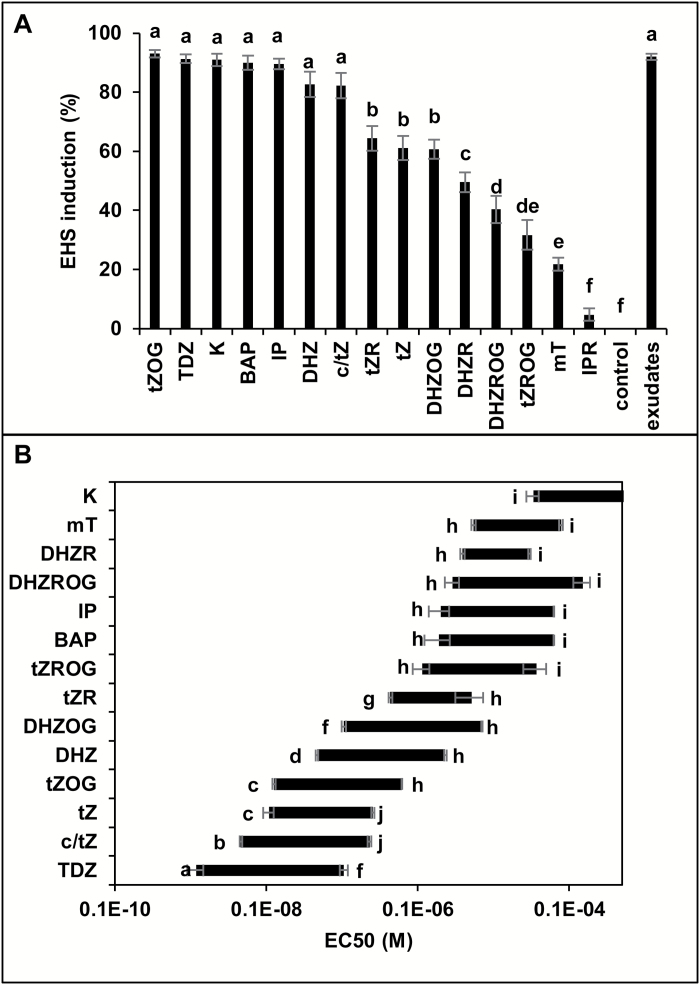
Effect of treatments with cytokinins on EHS induction. (A) Maximum EHS induction at the apex of P. ramosa germinated seeds after 72 h of treatment with an optimal concentration of tZOG (10–7 M), TDZ (10–8 M), K (10–4 M), BAP (10–5 M), c/tZ (10–7 M), DHZ (10–7 M), IP (10–5 M), tZ (10–7 M), DHZOG (10–6 M), tZR (10–6 M), DHZR (10–5 M), DHZROG (10–5 M), mT (10–5 M), IPR (10–5 M), and tZROG (10–6 M). Means are values ±SE (n=6). Values with the same letter are not significantly different from the control points (ANOVA P<0.01). (B) Concentration-dependent stimulation by tZOG, TDZ, K, BAP, c/tZ, DHZ, IP, tZ, DHZOG, tZR DHZR DHZROG, mT, and tZROG with concentrations ranging from 10–4 M to 10−10 M. EC50=half-maximal effective concentration. Means are values ±SE (n=6). Values with the same letter are not significantly different from the control points (ANOVA P<0.01).